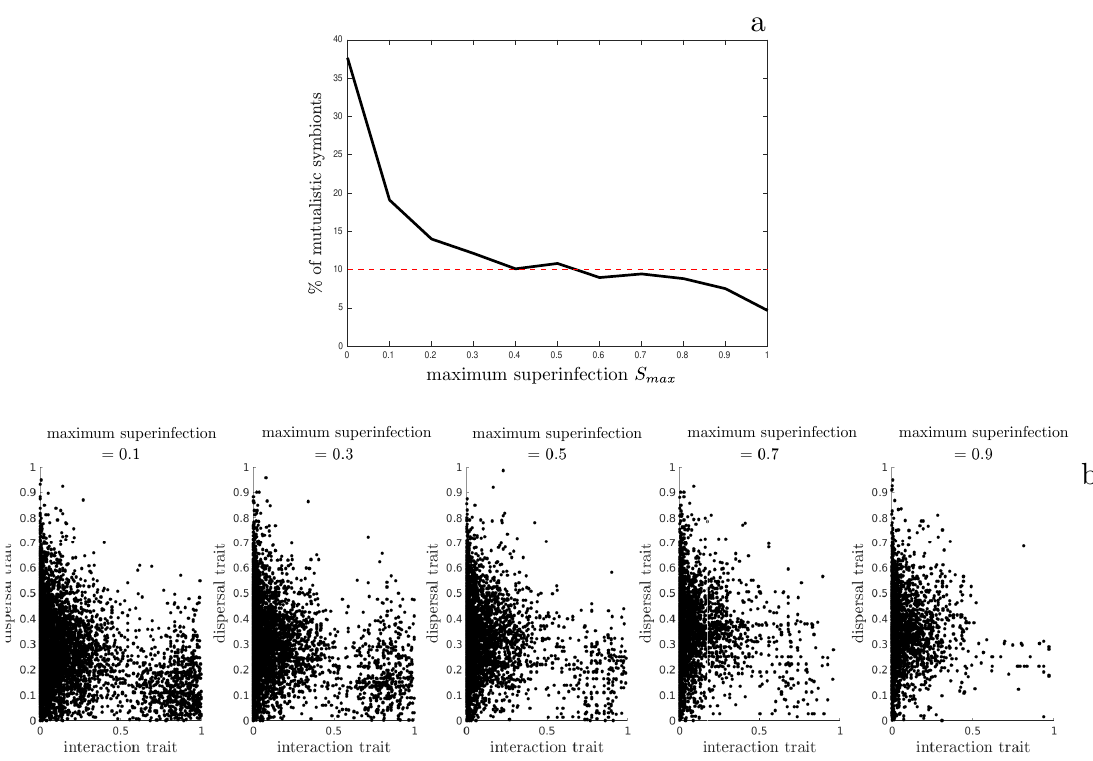
Figure SI.14. a) Percentage of mutualistic symbionts in function of the maximum superinfection advantage S max averaged over 20 simulations per parameter values. b) Distributions of symbionts population in traits domain according to five intensity of superinfection advantage S max . Distributions corresponds to 20 sim-